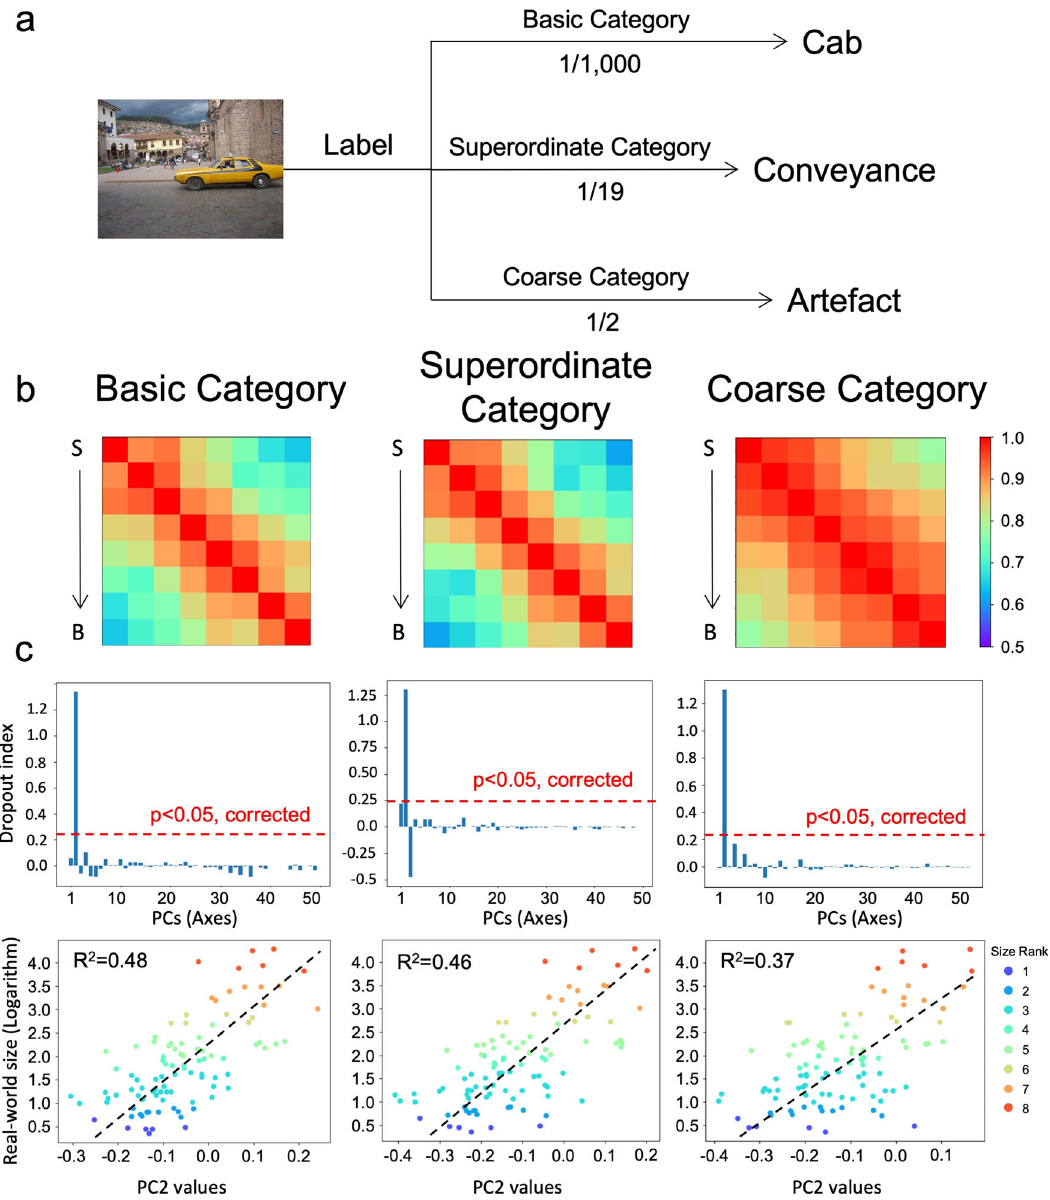
Fig. 4 Factors of objects ’ task demands in inferring objects ’ real-world size. a Task demands. Three DCNNs with the same architecture (i.e., AlexNet) were trained to classify objects at different levels of categorization. DCNNs were trained to categorize a car as cab (basic level), conveyance (superordinate level), or artifact (coarse level). Note that the DCNN for the basic-level categorization is the same as the one used in the previous experiments. b The RSM of Conv4 ’ s responses of the AlexNets with different task demands. From left to right: basic level, superordinate level, and coarse level. c The second axis of the object space also speci fi cally encoded the real-world size with the mapping function of the common logarithm. S small objects, B big